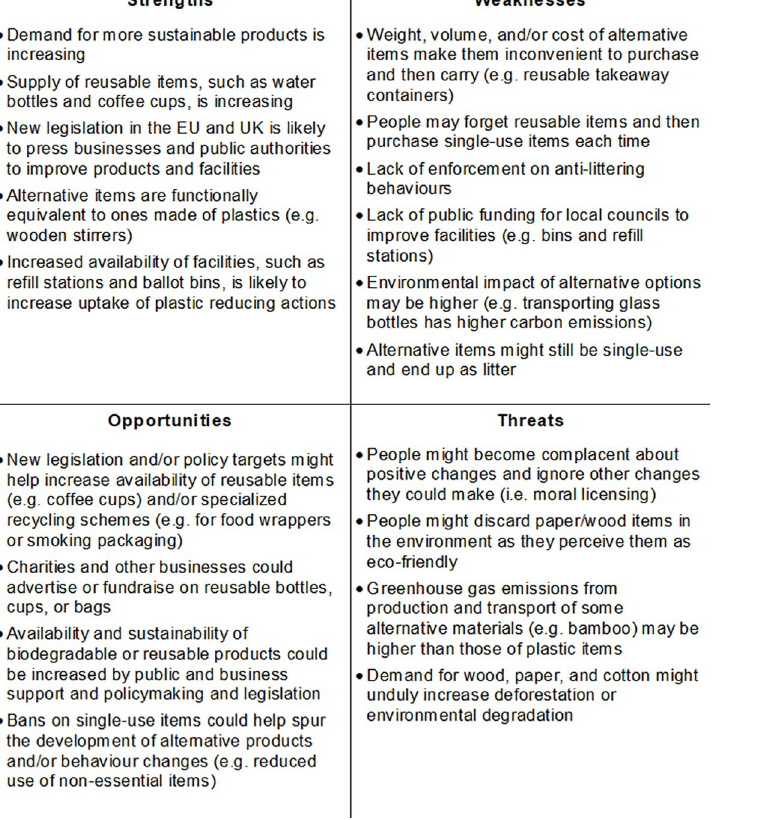
Fig 2. Synthesis of key findings from SWOT analysis (full results in S6 Table in S1 File).